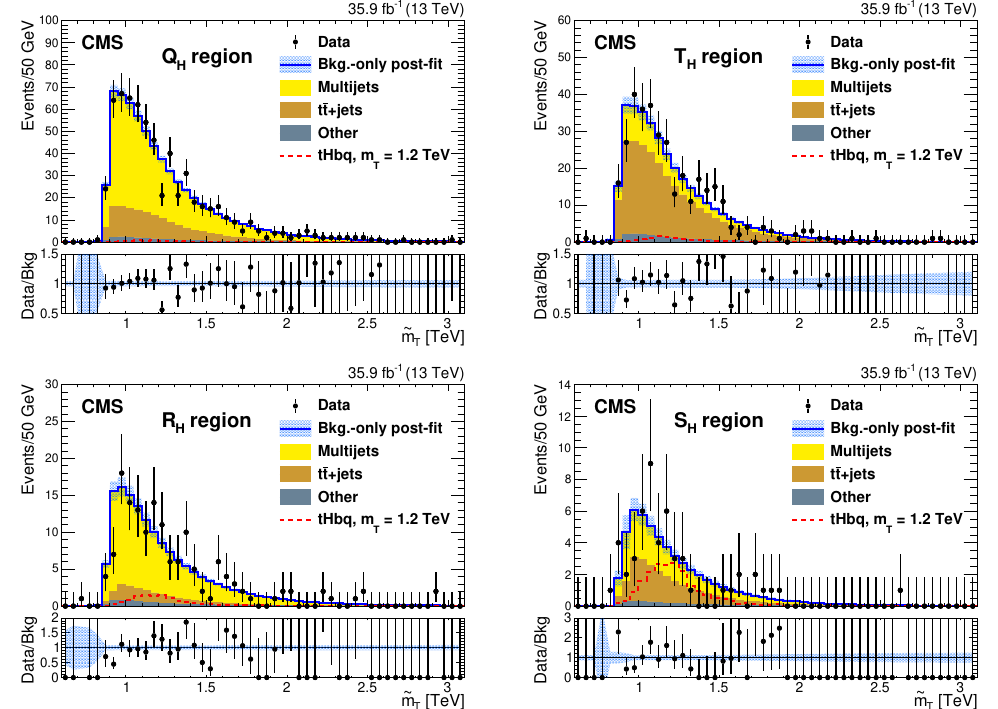
Figure 6 . The background-only post-(cid:12)t distributions in data for the Q that are used as signal and control regions primarily for the T ! tH channel. The upper plots show regions Q (left) and T (right), while the lower plots show regions R H H dashed red histogram is an example T ! tH signal for the tHbq process with a 1.2 TeVT quark mass and a fractional width of 30% with a cross section from the singlet model of 142 fb. The lower panels show the ratio of observed data to (cid:12)tted background per bin. The error bars on the data represent 68% CL Poisson intervals. The light blue band in each ratio panel shows the fractional uncertainties in the (cid:12)tted